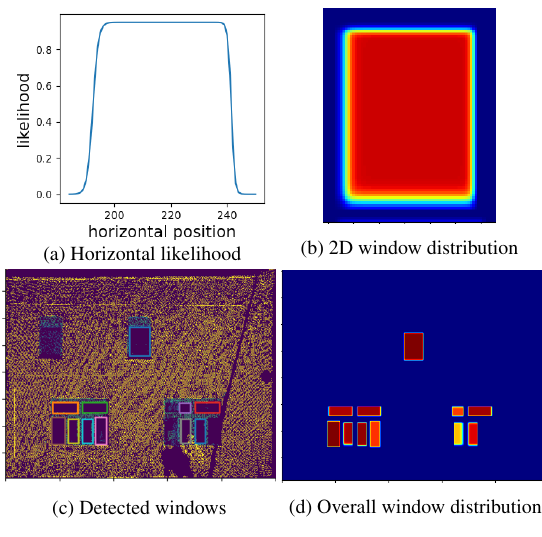
Figure 4. The uncertainty of